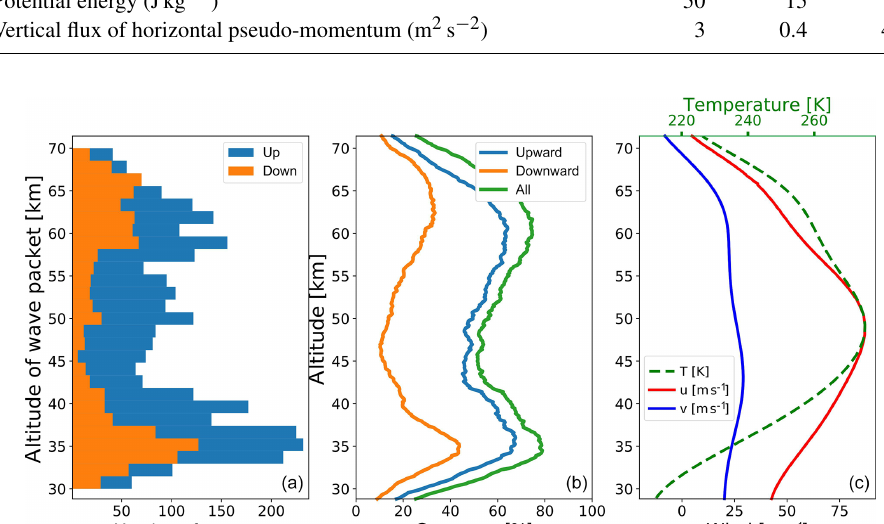
Figure 9. (a) Number of waves detected per 1.5km altitude range bin. Blue (orange) bars mark upward-propagating (downward-propagating) GWs. (b) Mean coverage by detected waves when taking the altitude extent of the waves into account. The green profile indicates whether a wave was found, whereas blue and orange lines are for upward- and downward-propagating waves, respectively. (c) Background mean wind and